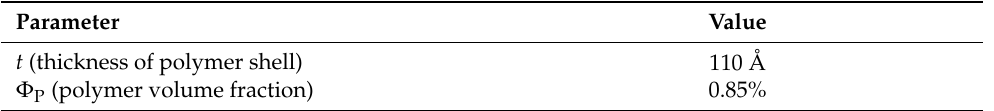
Table 6. Parameters obtained from fitting the core–shell cylinder model to the data of 0.5